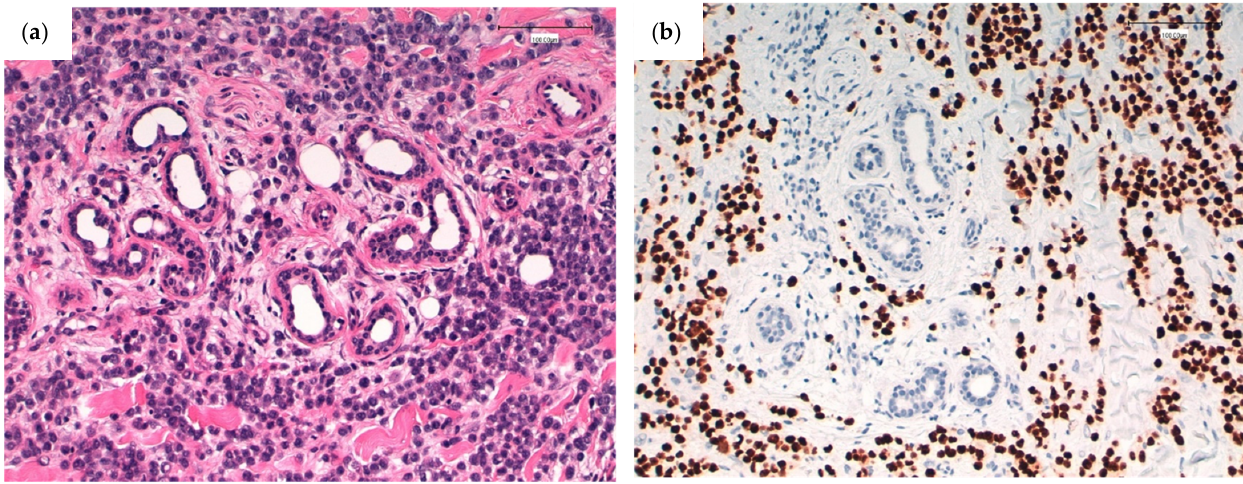
Figure 3. (a) Cutaneous metastasis from a lobular carcinoma. Discohesive, monomorphic cells surrounding a cutaneous appendage. H&E; original magnification, 200×. (b) High expression of estrogen receptor (Clon EP1, Agilent). Original magnification, 200×.